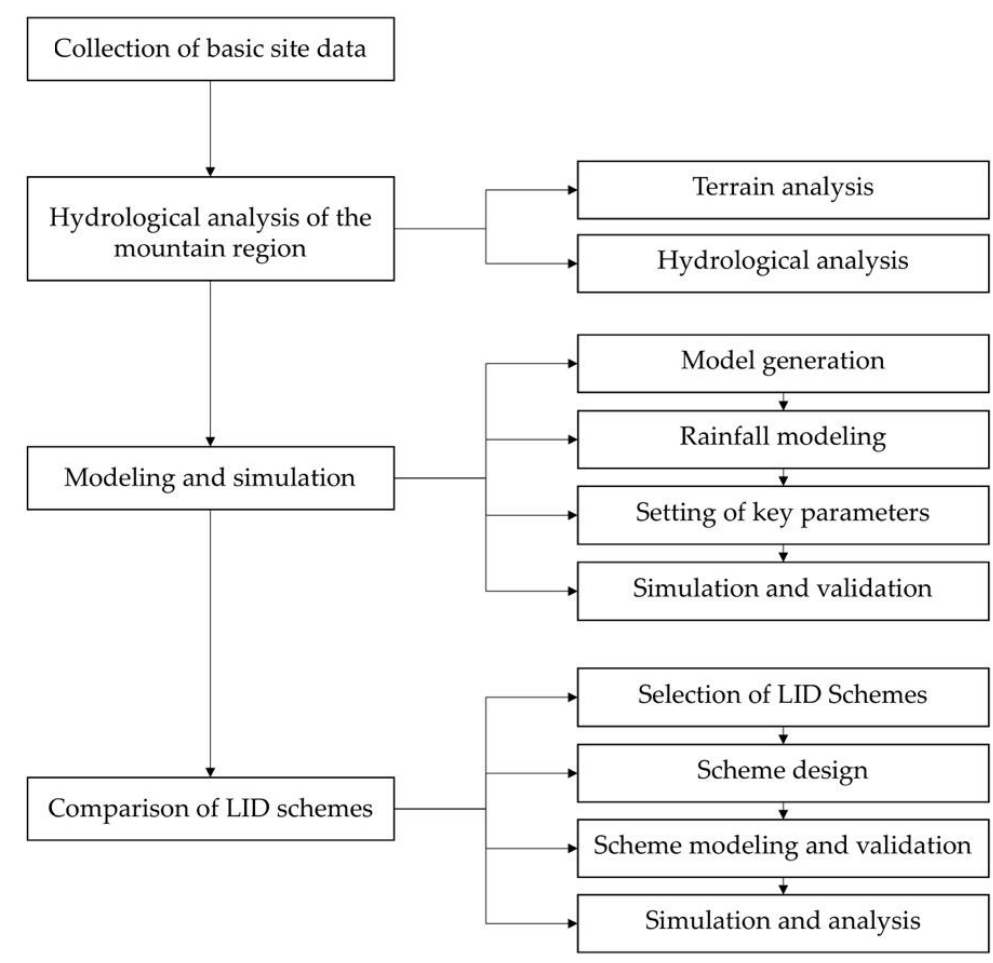
Figure 1. Overview of Technical Research Approach.